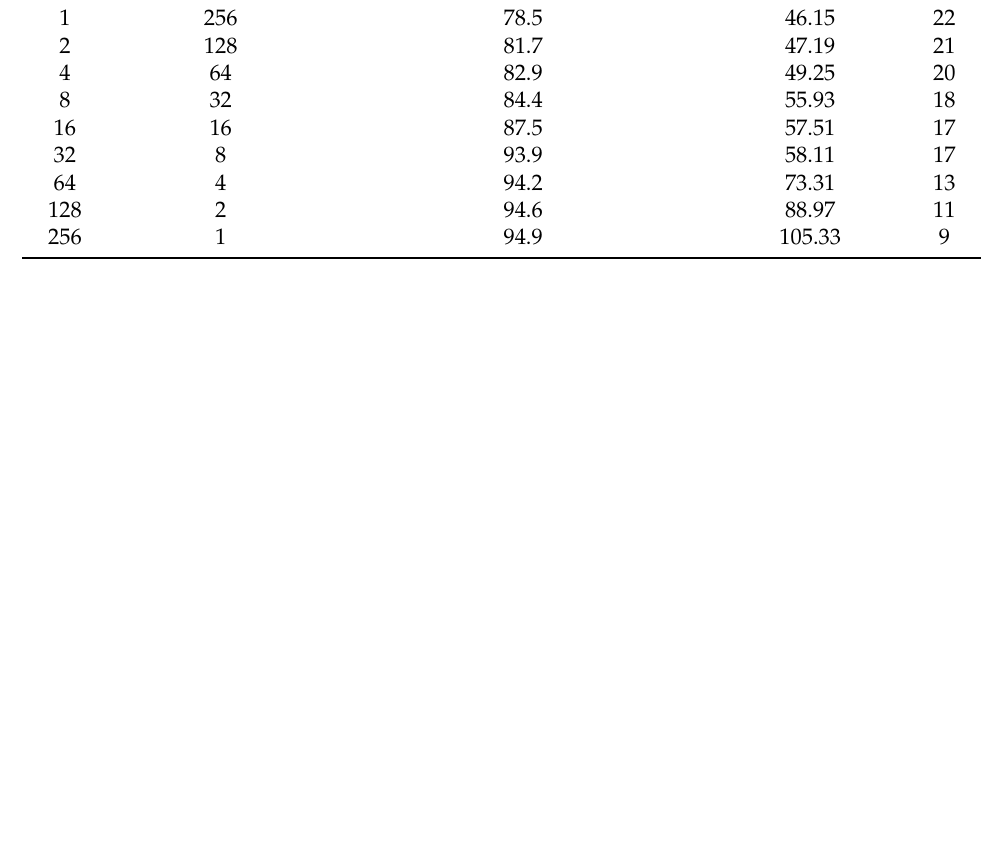
Table 2. Cell activation detection error as a function of the refresh rate.